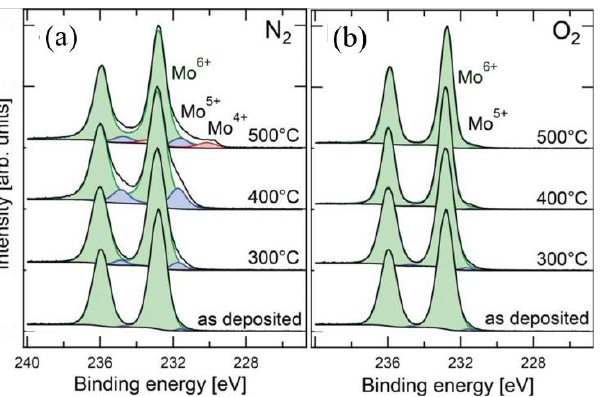
Figure 7. X-rays photoelectron spectroscopic (XPS) spectra of Mo 3d, showing the effect on annealing temperature and ambient: ( a ) N 2 , ( b ) O 2 . Reprinted with permission from [123]. Copyright 2014 American Chemical Society.